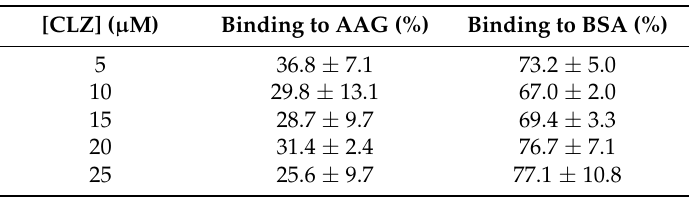
Table 3. Percentage protein binding for both AAG and BSA (normalized for screening from the fouling coefficients) across varying concentrations of CLZ. Values displayed as mean ± standard deviation n =